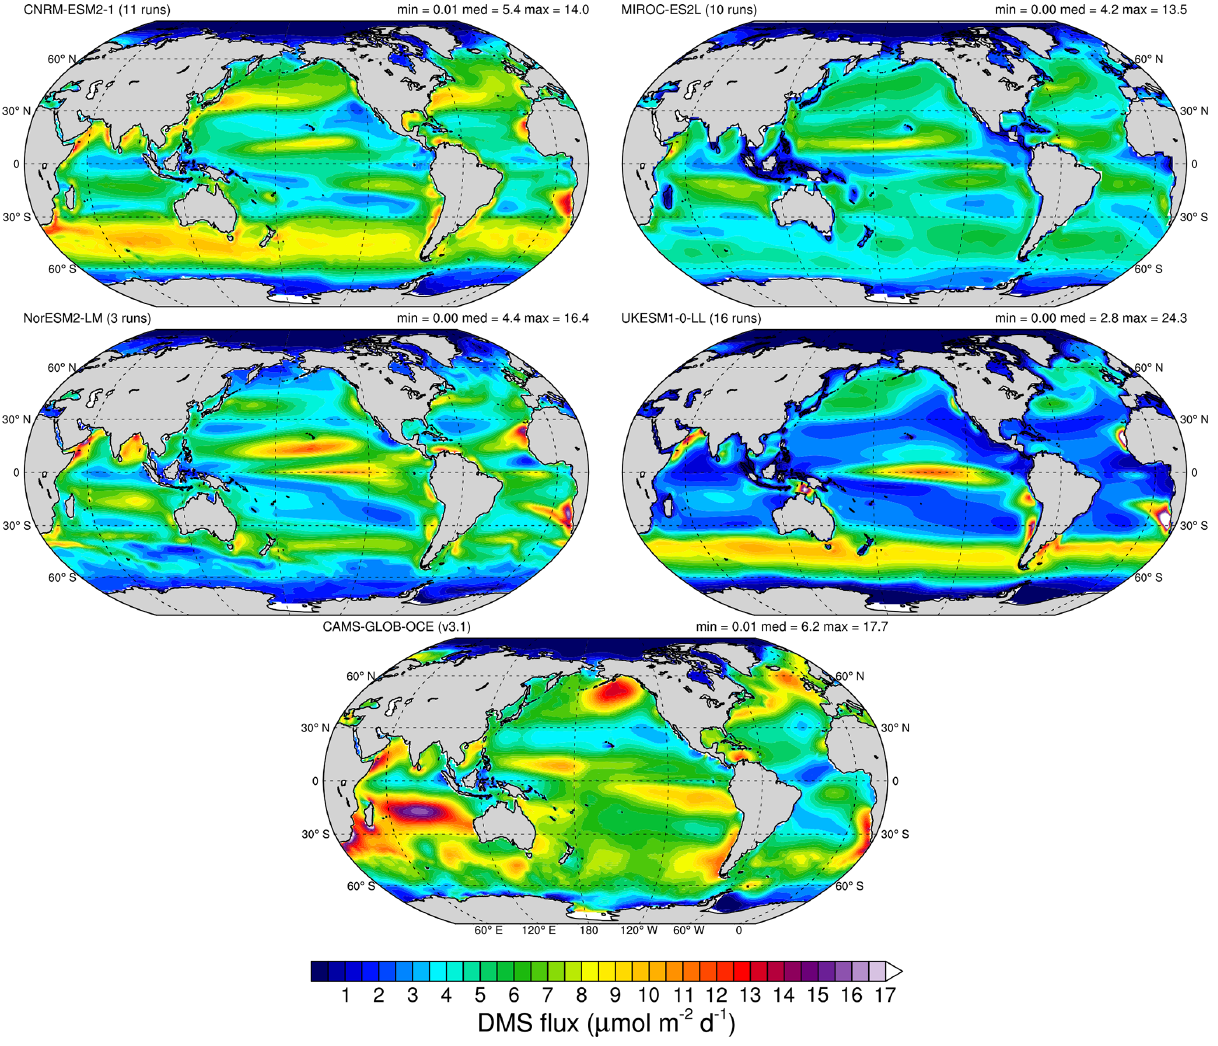
Figure 6. Annual mean DMS flux (µmolm − 2 d − 1 ). First two rows: 1980–2009 means for the four CMIP6 models. Last row: CAMS19. Minimum, area-weighted median, and maximum are provided for each